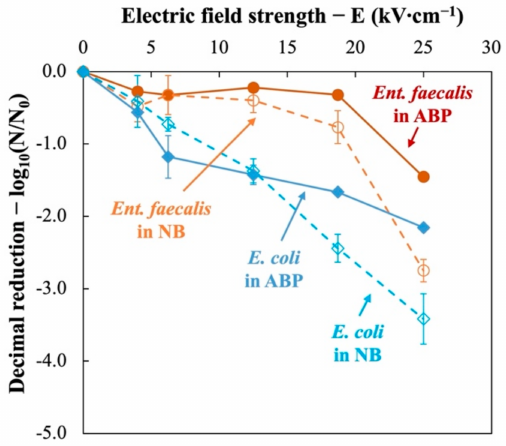
Figure 3. Inactivation kinetics of Ent. faecalis (red) and E. coli (blue) subjected to pulsed electric field (PEF) treatment in nutrient broth (NB, dotted lines) and animal by-products (ABP, solid lines). For Ent. faecalis , slight inactivation (<0.4 log10) can be obtained when electric field var- ied between 0 and 18.5 kV · cm − 1 . When electric field intensity increases from 18.5 kV · cm − 1